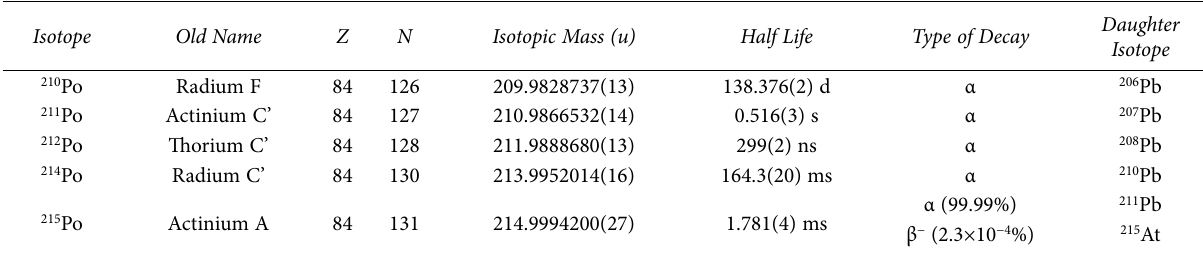
Table 1. The Naturally Occurring Isotopes of Polonium. Isotope